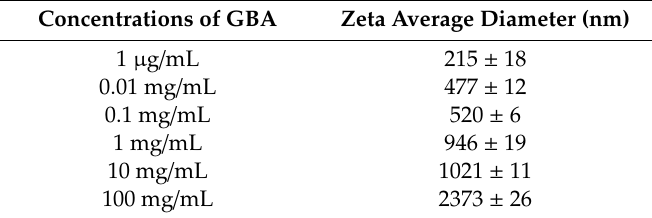
Table 2. Z-Average diameter of di ff erent concentrations (1 µ g / mL, 0.01 mg / mL, 0.10 mg / mL, 1.00 mg / mL, 10.00 mg / mL, and 100.00 mg / mL) of GBA suspension in water after incubation at 37 ◦ C for 30 min and supplementation with 10%